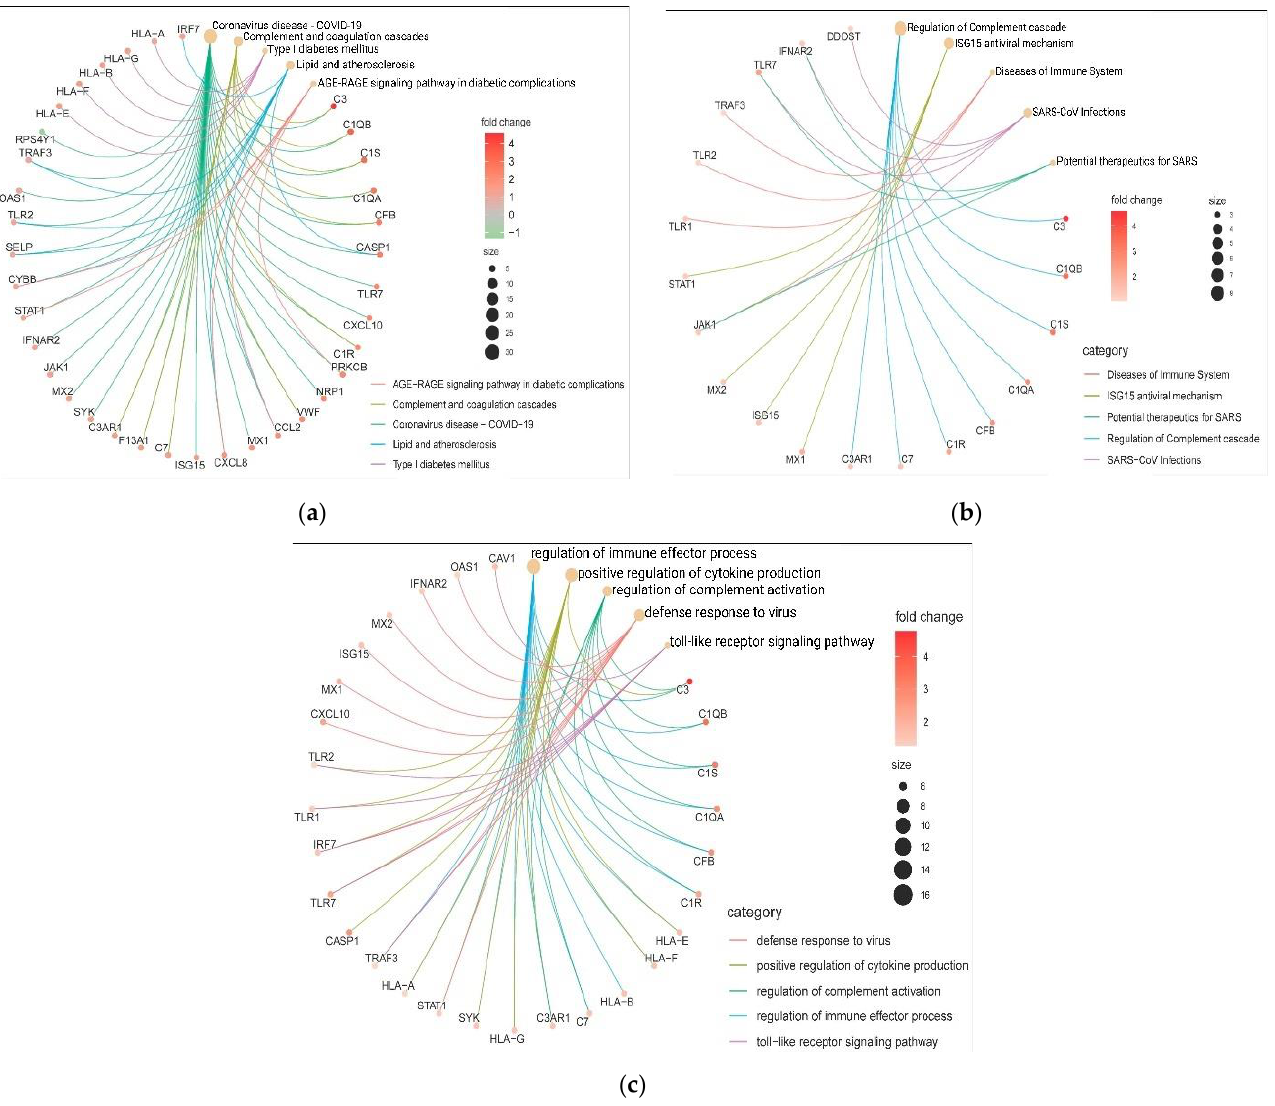
Figure 7. Category cnetplot depicts the linkages of upregulated genes and the biological pathways as a network. Cnetplot of ( a ) KEGG, ( b ) Reactome, and ( c ) Biological process shows the pathways and associated 41 up-DEGs networks. Red (light to dark) nodes indicate the Log2FC values, while yellow nodes indicate the functional enriched pathways whose size represents the number of genes that are DEGs in each of them.